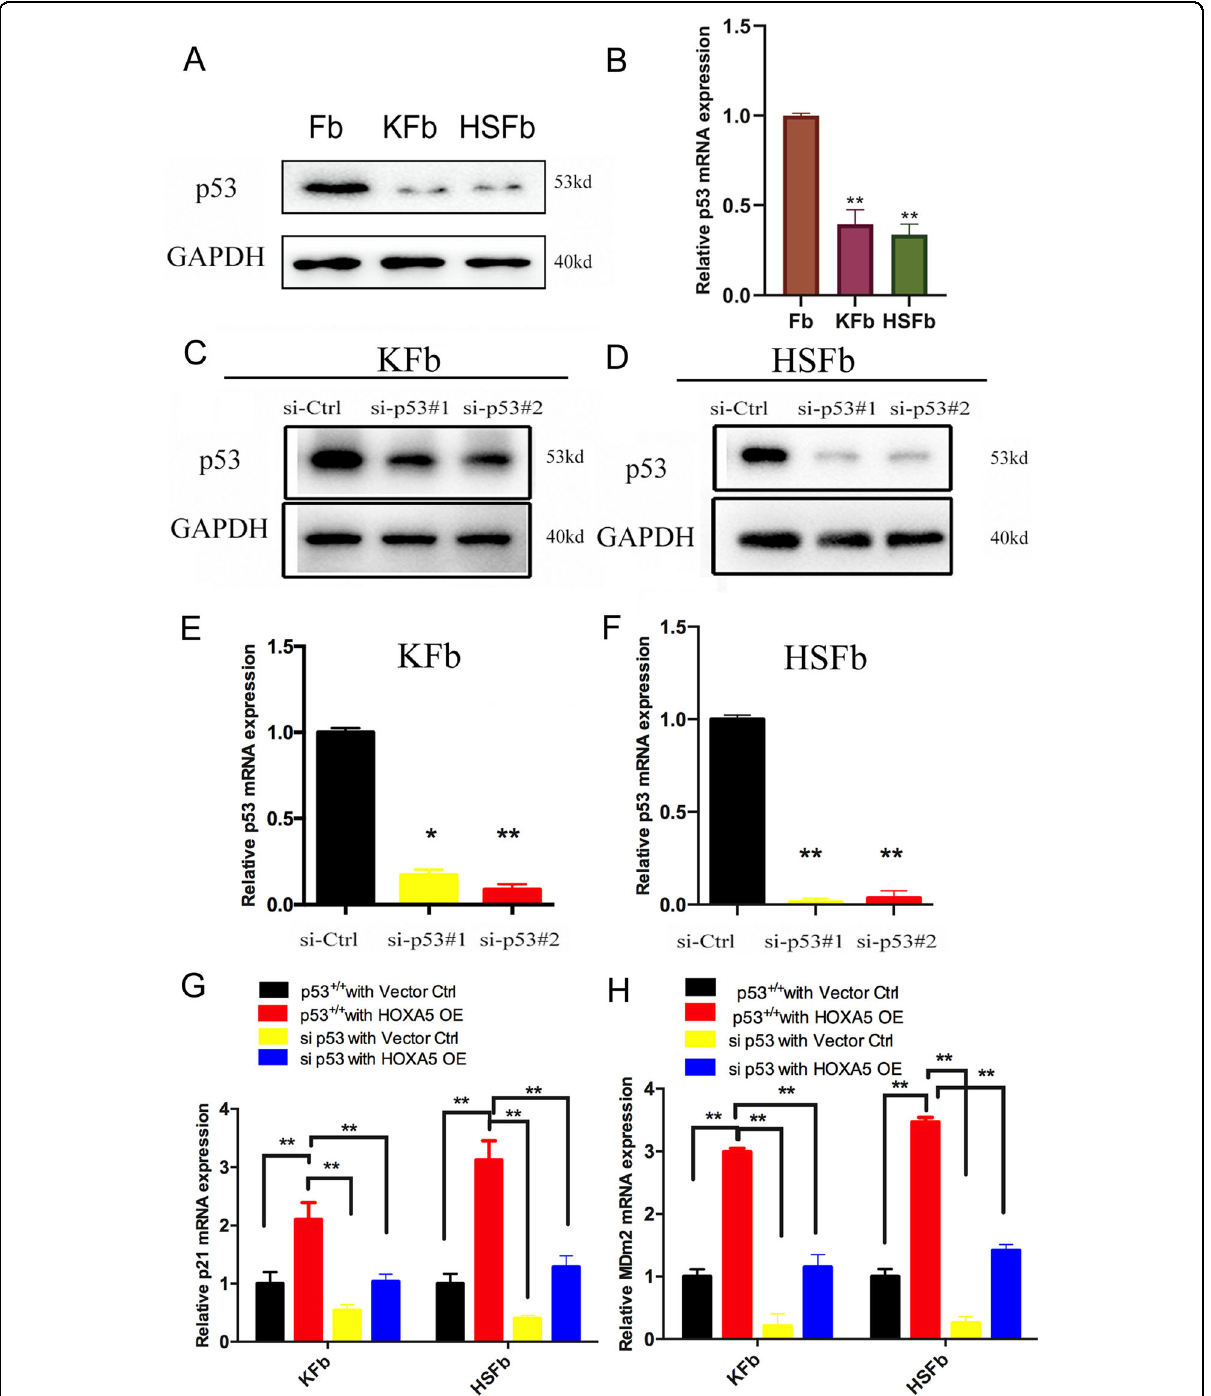
Fig. 4 Knockdown of p53 in both the HSFb and the KFb. A , B The expression of p53 in KFb, HSFb and normal fi broblasts was detected by qPCR and western blot. C , D p53 protein levels in KFb and HSFb were detected by western blot. E , F p53 mRNA levels were detected by QPCR in KFb and HSFb. G , H Knockdown of p53 partially weakened the HOXA5-mediated regulation of p21 and Mdm2 in KFb and HSFb. * p < 0.05, ** p <